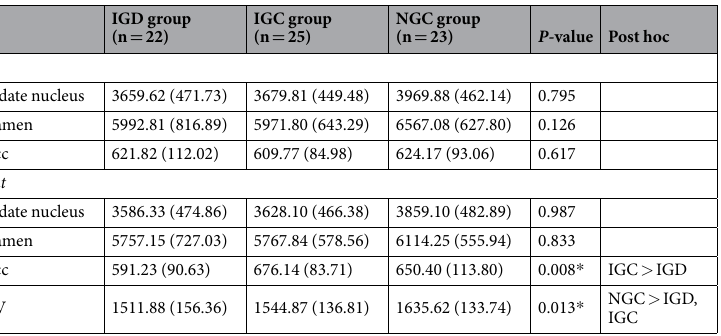
Table 2. The volumes of the striatum. Abbreviations: eTIV, estimated total intracranial volume; IGC, internet gaming control; IGD, internet gaming disorder; NAcc, nucleus accumbens; NGC, non-gaming control. * Significant at P <